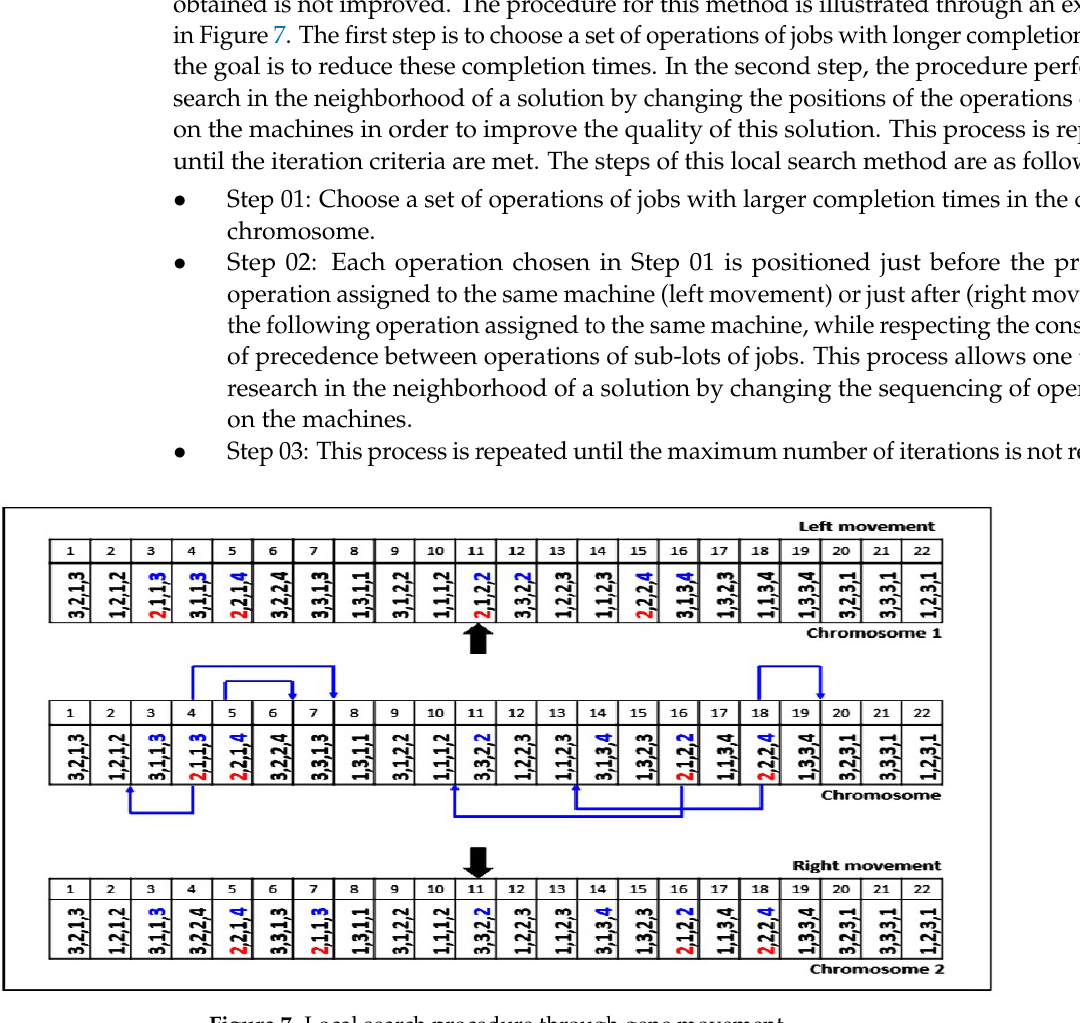
Figure 7. Local search procedure through gene